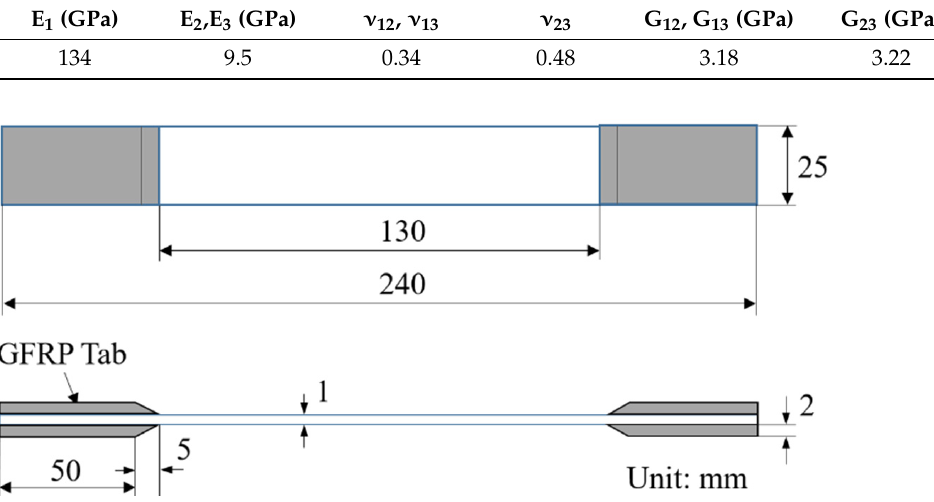
Figure 1. Dimensions of the tensile specimen of the [0/ θ ] 2s